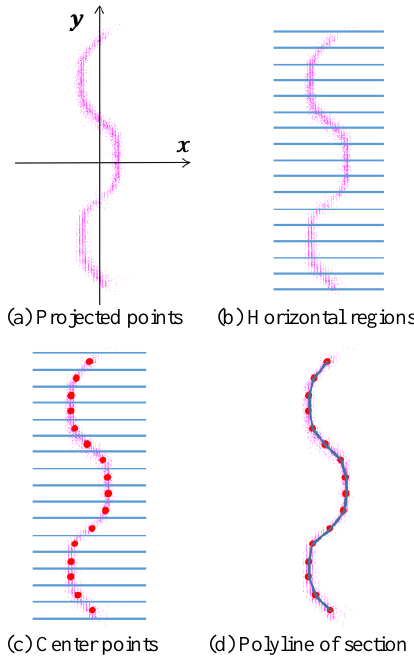
Figure 19. Skeleton of beam